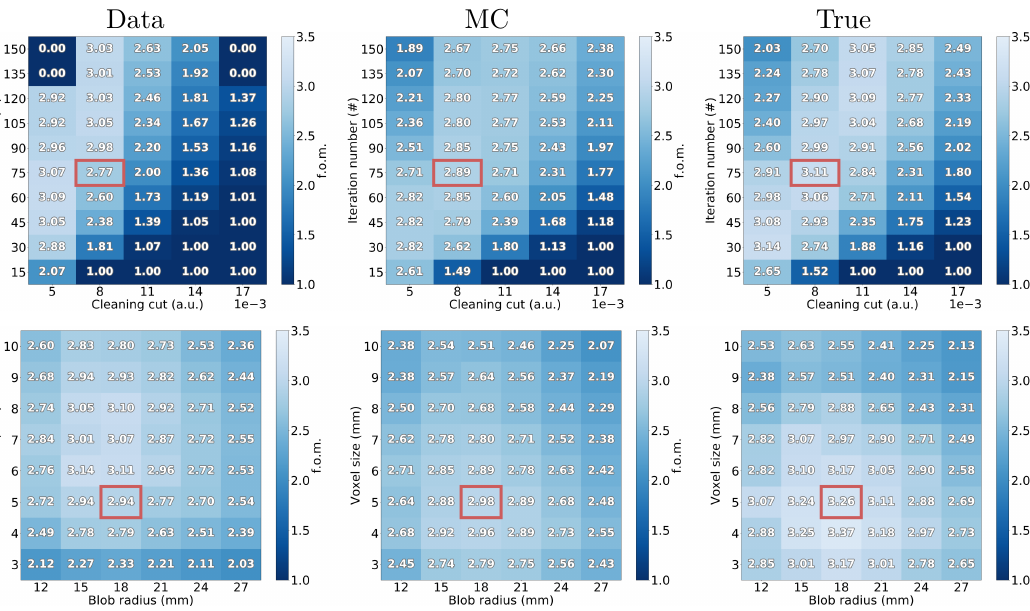
Figure 17 . Variation of the maximal f.o.m. achieved for both experimental detector data and MC for different cuts on the input signal. The scan on q cut was done with fixed values for the other parameters, as described in the text.